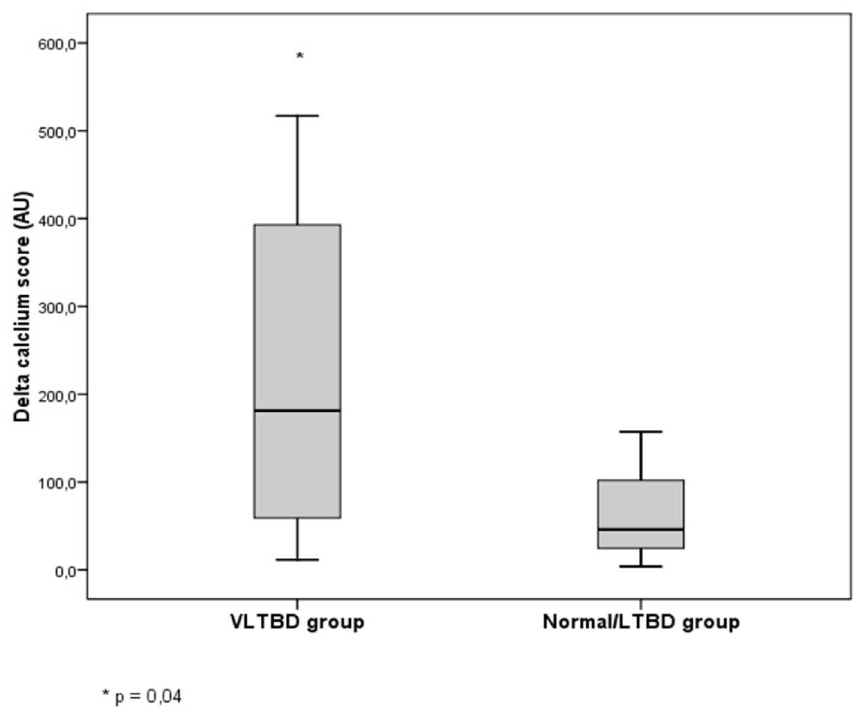
Fig 3. Comparison of delta calcium score between very low (VLTBD) and normal/low (LTBD) turnover bone disease groups.